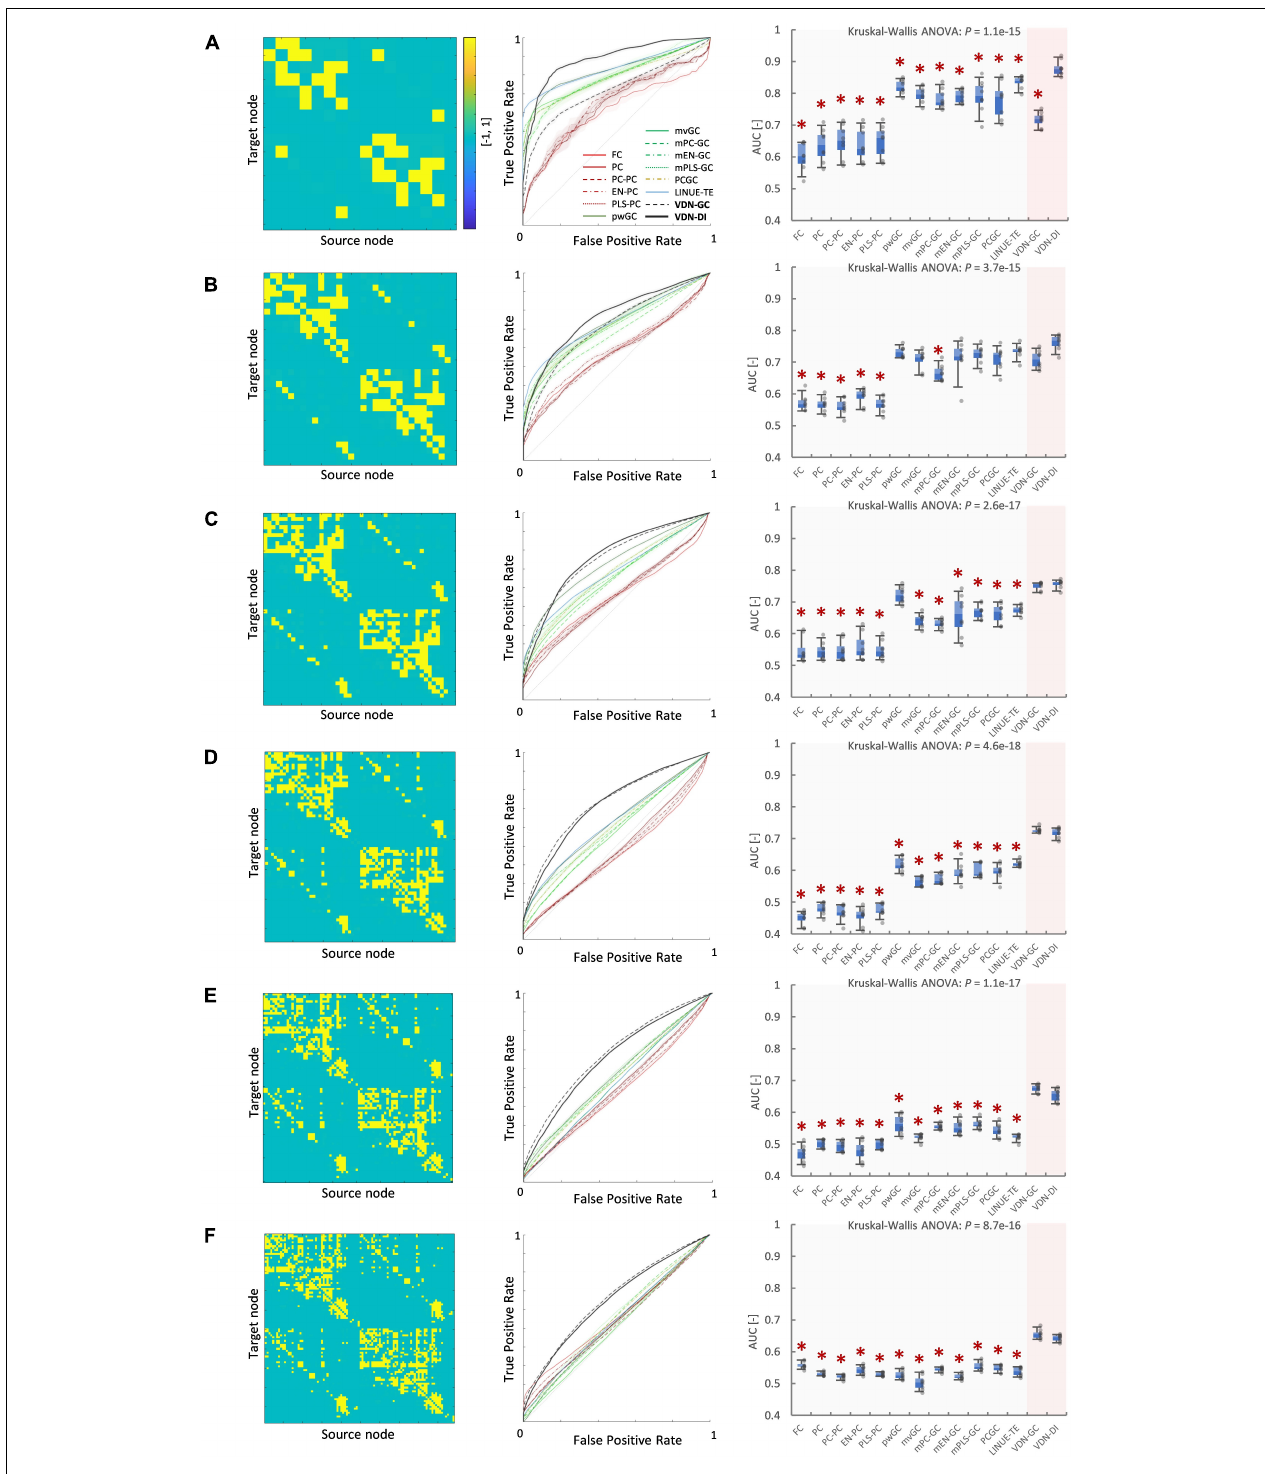
FIGURE 6 | (A) Fully connected 16-node network with strong weight (| cij| > 1) network density 0.15. Node signals were generated by the reduced Wong-Wang model from the TVB software. From left to right images show the global coupling matrix C for the reduced Wong-Wang model, the ROC curve result of ground truth estimation by each analysis algorithm, and the box-plot of AUC results, respectively. Color bar shows matrix C- value for (A–F) . In the box-plot, black dot shows each experimental result and red asterisks denote a significant difference from VARDNN-DI to other algorithms by the Steel test (* p < 0.05) ( N = 8). (B–F) Results for the 32-node, 48-node, 64-node, 80 node, and 98-node networks,